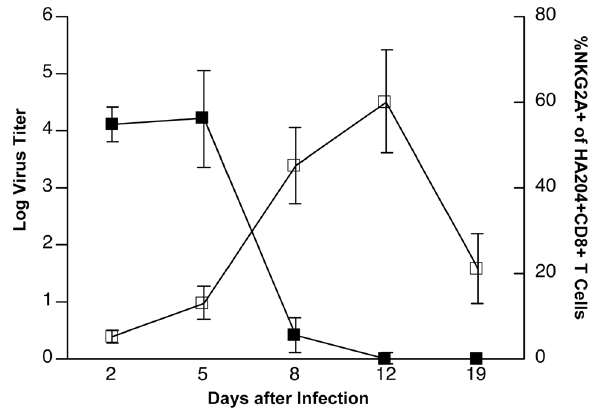
Figure 1. NKG2A 2 / 2 expression inversely correlates to influ- enza viral load with peak expression at 12 days p.i. Mice were intranasally infected with a 0.5LD 50 Influenza A/PR8/34 virus and sacrificed on the indicated days post infection. Whole lung viral titers were determined by the TCID 50 assay, solid black squares. In parallel, lungs were harvested and NKG2A expression on NP 366 -specific CD8 + T cells was determined by FACS on the indicated days post- infection, open squares. Data are representative of at least 3 independent experiments.